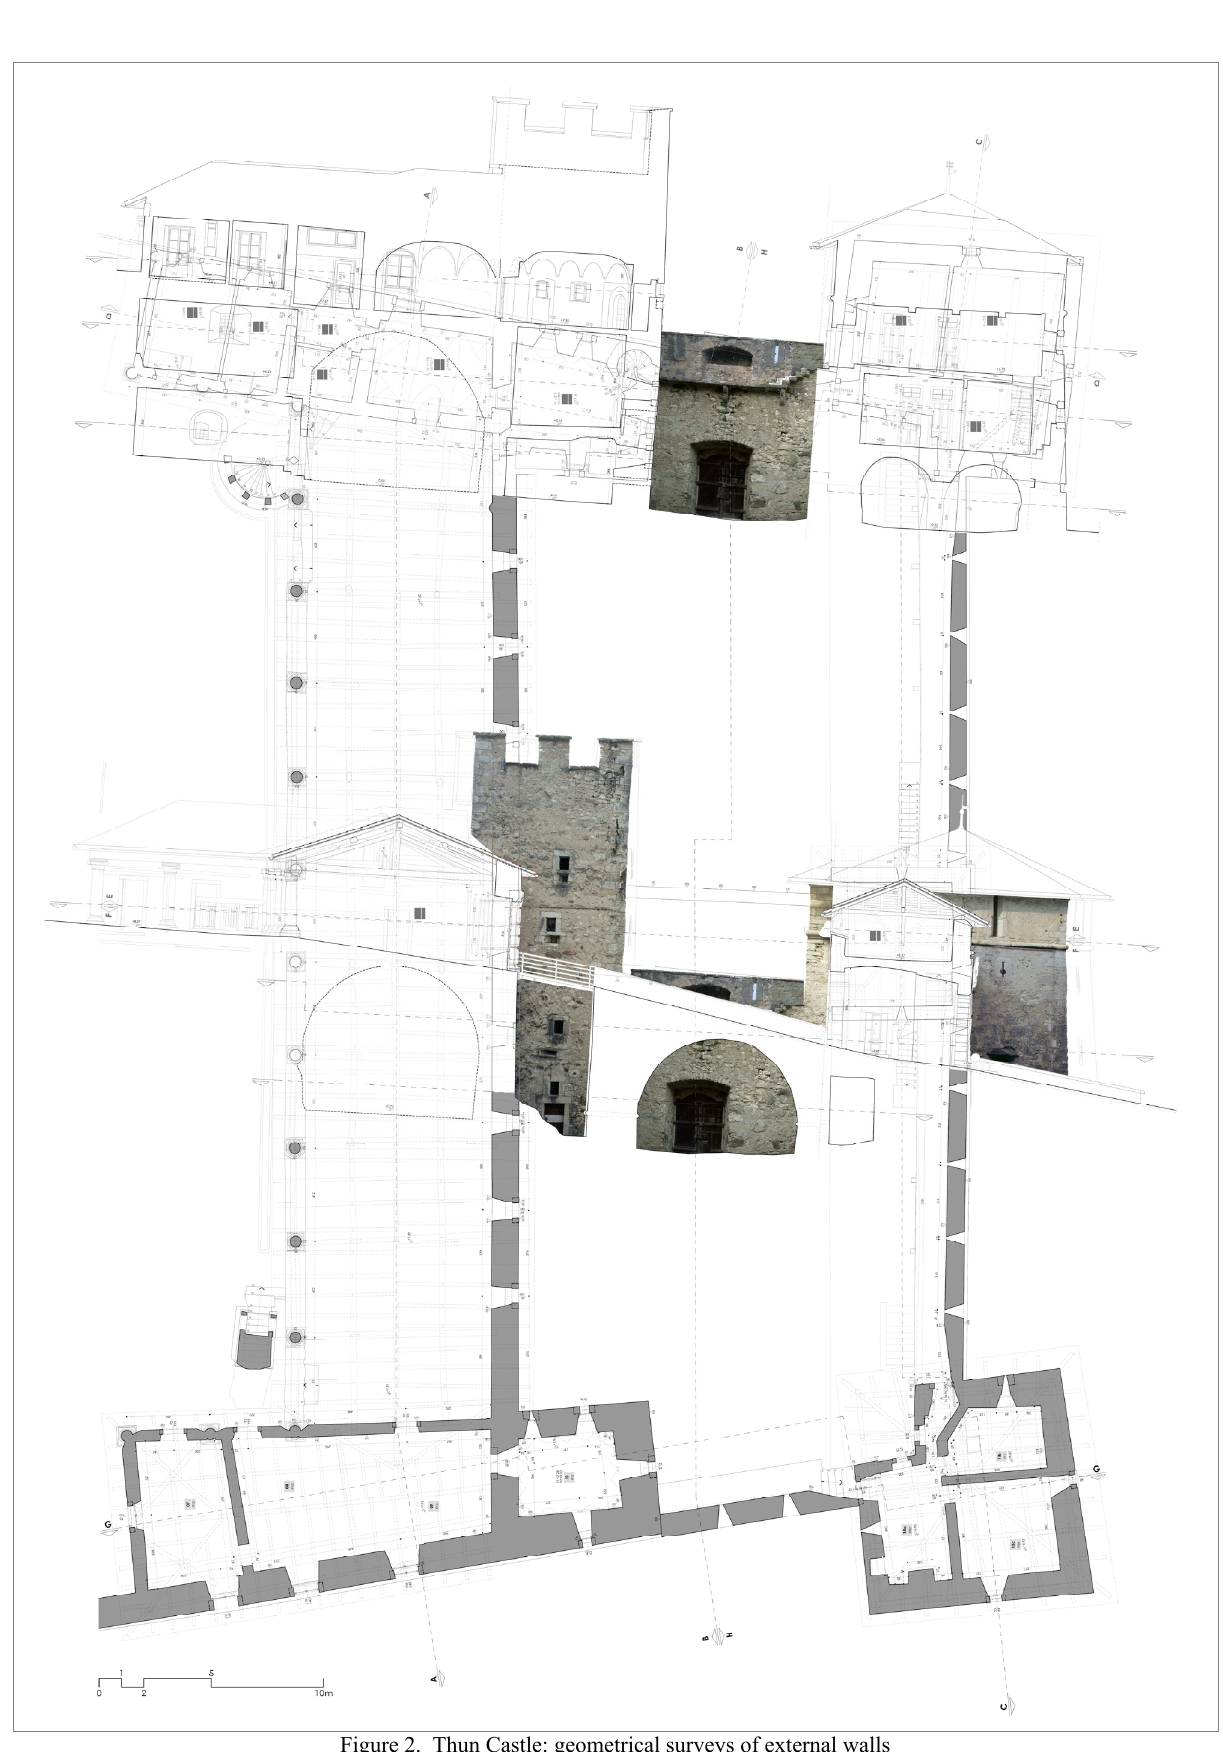
Figure 2. Thun Castle: geometrical surveys of external